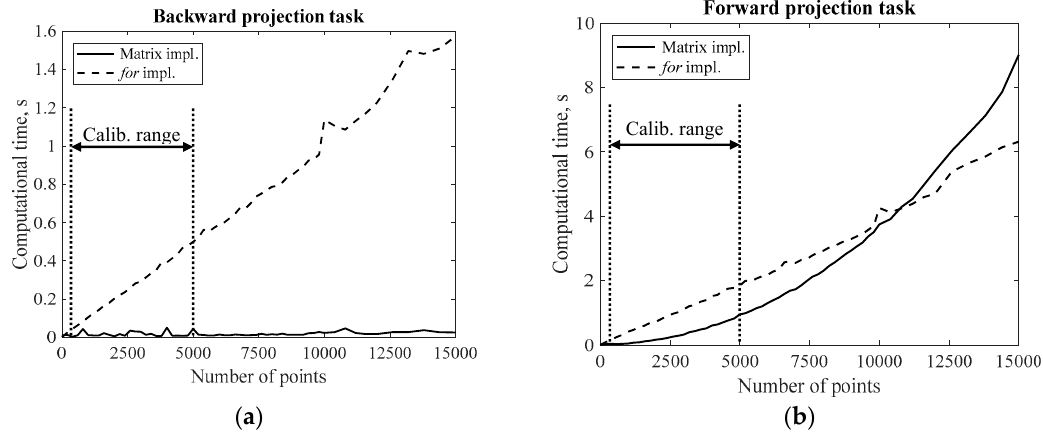
Figure 4. Code performances for an increasing number of points: ( a ) BP task and ( b ) FP task.